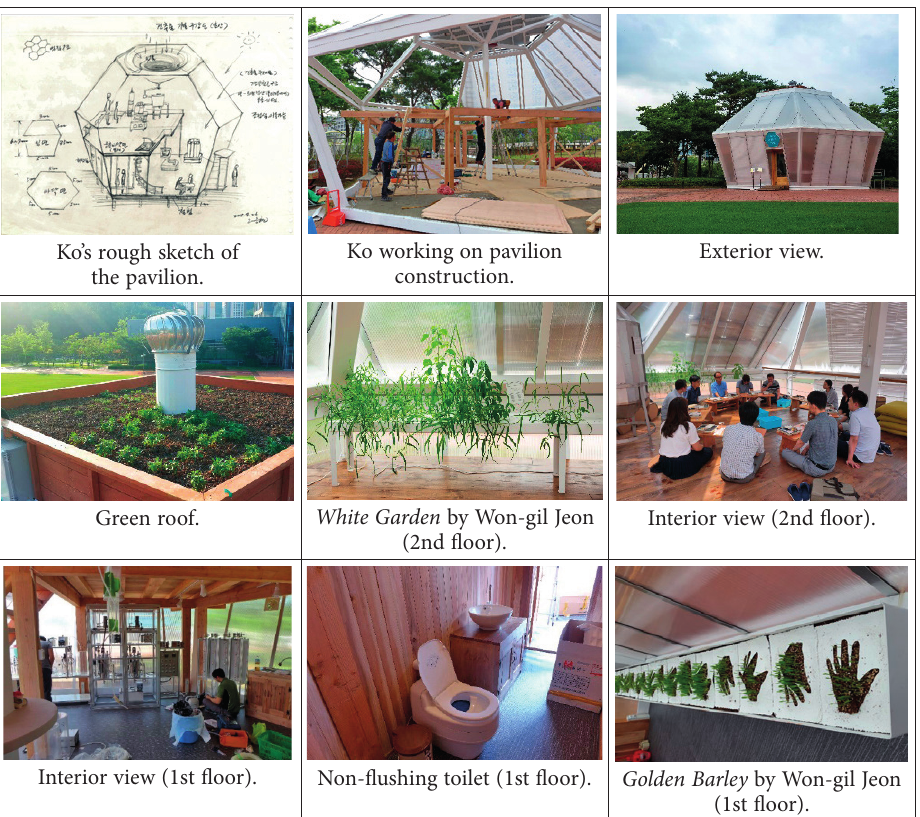
Table 5. Interior and exterior views of pavilion (source: Courtesy of Yatoo and Science Walden )